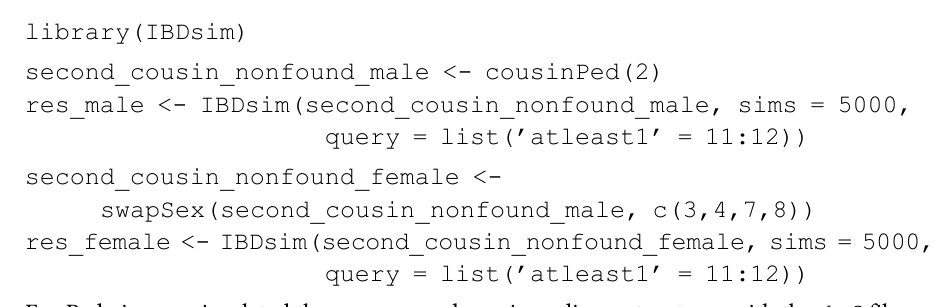
S1 Fig. Differences in true and predicted IBD sharing fractions of full siblings from simu- lated nuclear families. IBD sharing fractions are from the full sibling pairs of 500 simulated nuclear families with three children (left) and 500 with five children (right). We phased these families and extracted IBD sharing estimates as described in Methods. S2 Fig. IBD sharing fraction 25th and 75th percentiles in full siblings and standard devia- tions in first through second cousins from real and simulated data. Points are from the SAMAFS, SAMAFS-validated subset (except full siblings), Hemani20k set (only full siblings), and the simulation models. The latter are labeled using abbreviations given in the main text. Bars indicate 95% confidence interval ( ± 1.96 standard errors) as calculated from 1,000 boot- strap samples. SD indicates standard deviation. (TIF) S3 Fig. Mean, minimum, median, and maximum IBD sharing fractions in real and simu- lated data for full siblings through second cousins. Points are from the SAMAFS, SAMAFS- validated subset (except full siblings), Hemani20k set (only full siblings), and the simulation models. The latter are labeled using abbreviations given in the main text. The SAMAFS and SAMAFS-validated values are mean-shifted to match expectations for the first cousins, first cousins once removed, and second cousins, but are unaltered for the full sibling and the full sibling IBD2 quantities. Bars indicate 95% confidence interval ( ± 1.96 standard errors) as calcu- lated from 1,000 bootstrap